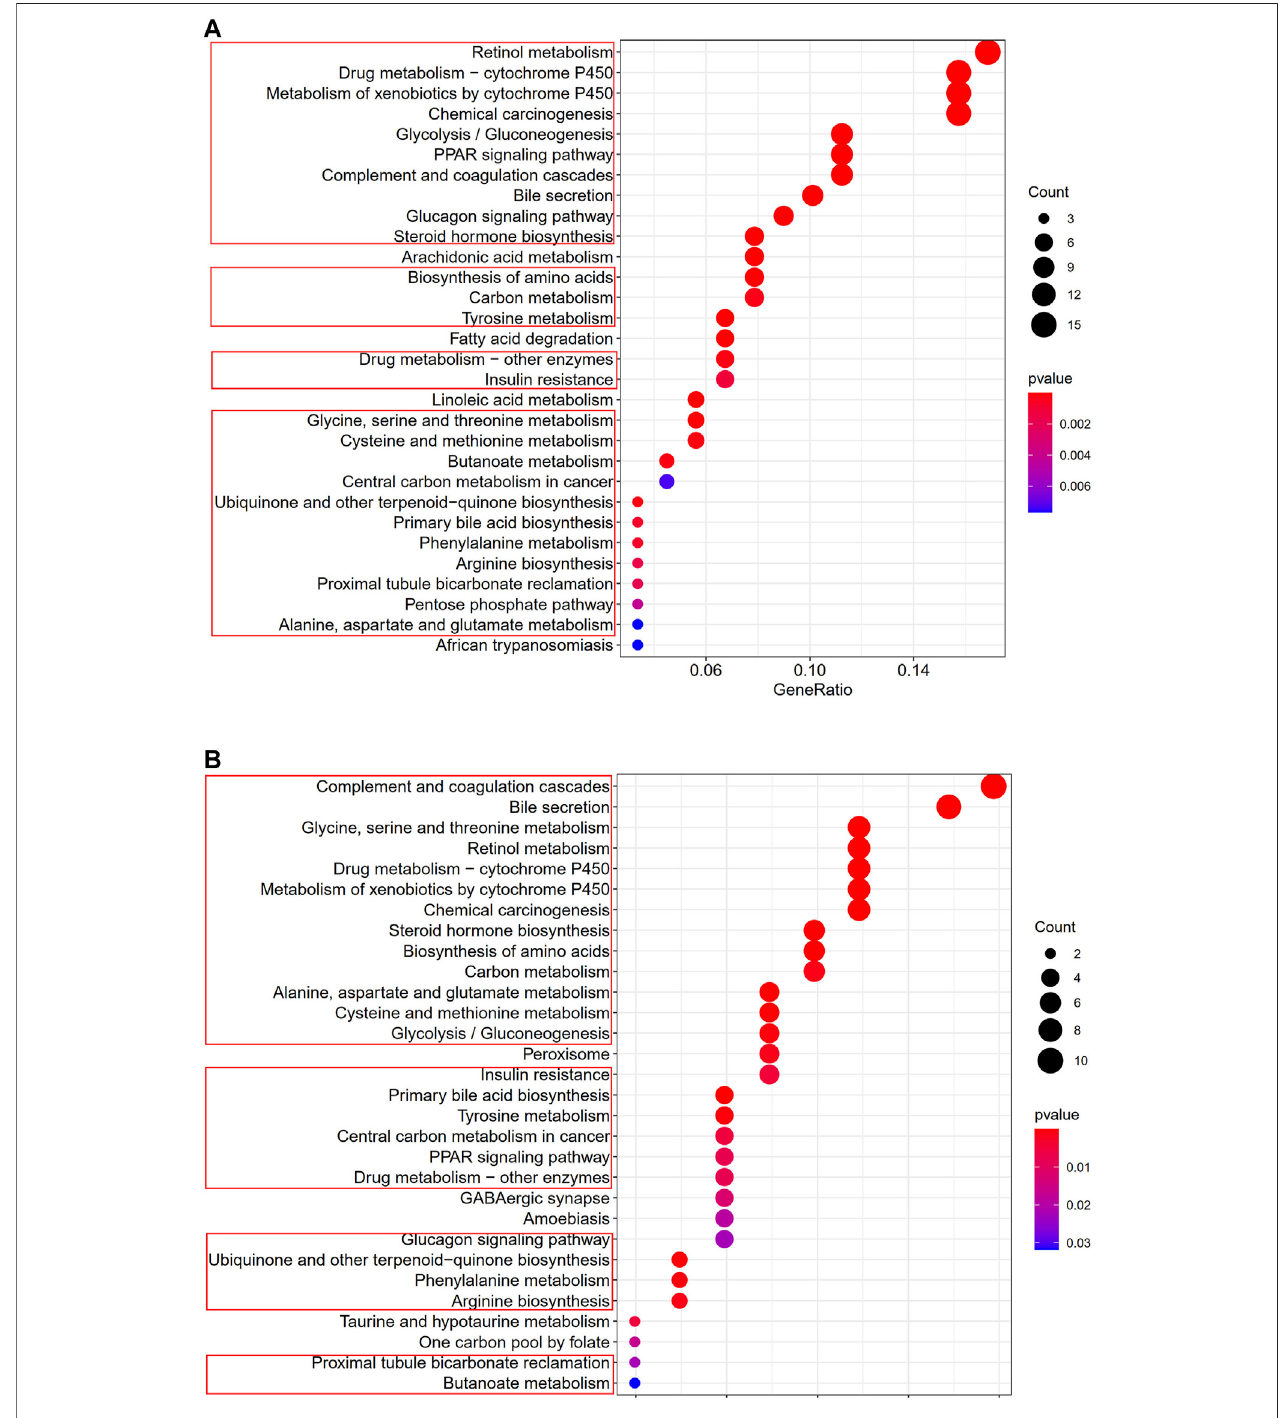
FIGURE 10 | Representative results of KEGG analyses (A) KEGG pathways in the TCGA cohort. (B) KEGG pathways in the GSE14520 cohort.